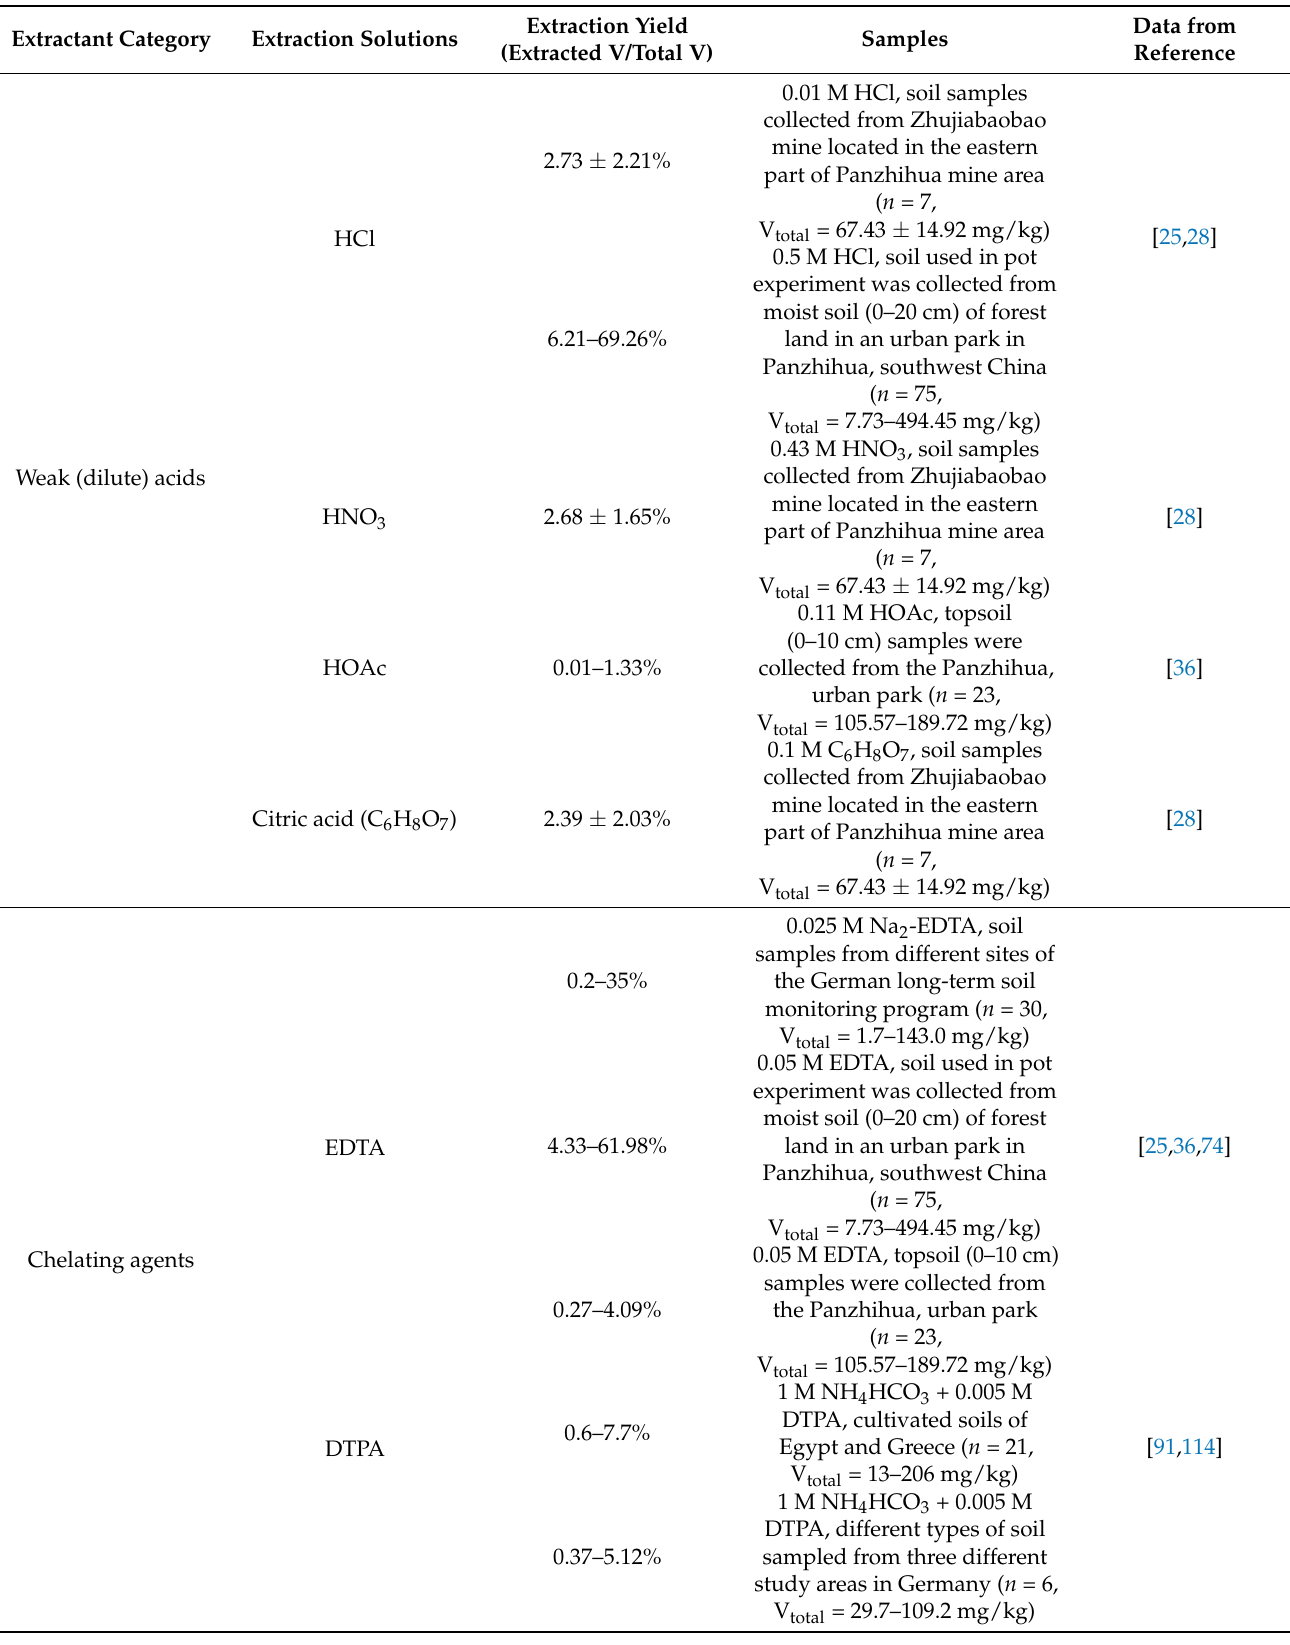
Table 3. Comparison of the V extracted by single-step extraction